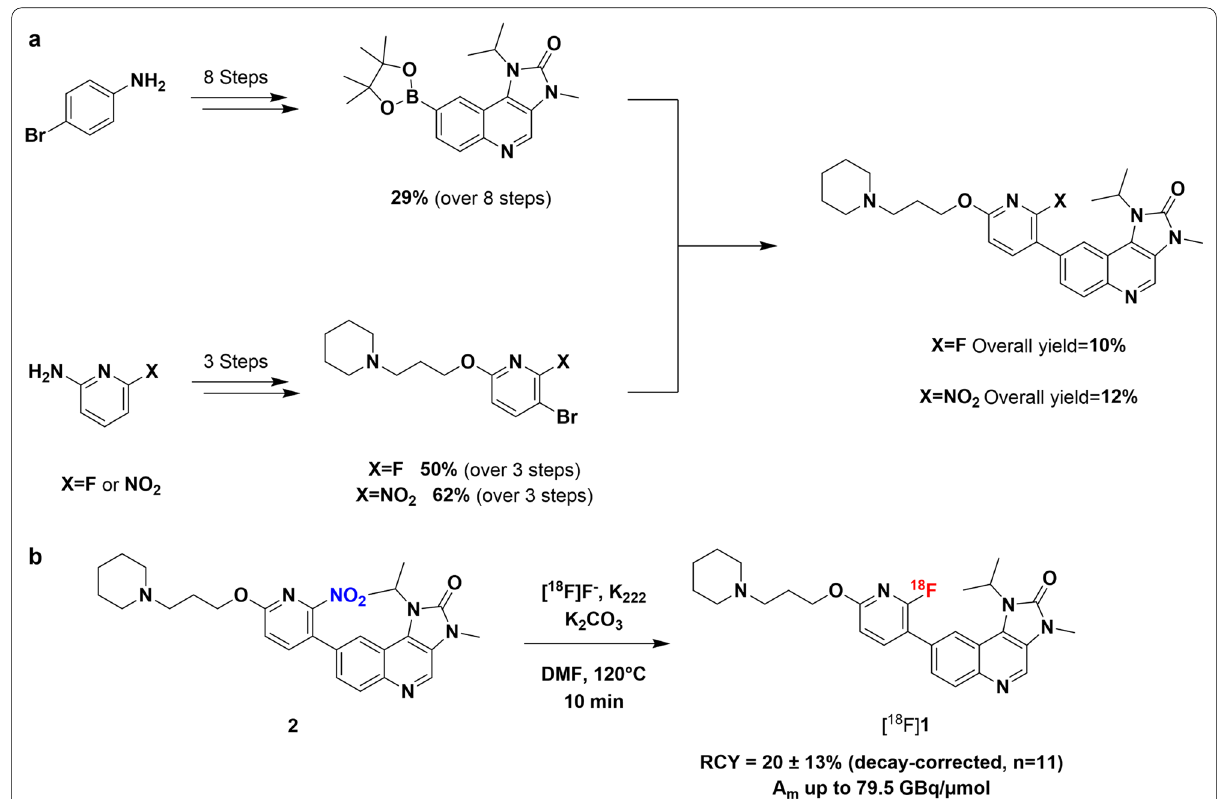
Fig. 2 a Synthetic pathway to reference [ 19 F] 1 and nitro-precursor 2 . b Radiosynthesis of [ 18 F] 1 from